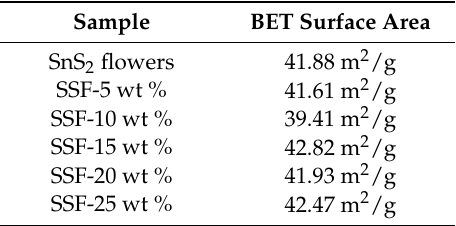
Table 1. Brunauer–Emmett–Teller (BET) surface areas of various SnS 2 -SiO2@ α -Fe2O3 (SSF-X) (X = 5, Table 1. Brunauer – Emmett – Teller (BET) surface areas of various SnS 2 - SiO2@α -Fe2O3 (SSF-X) (X = 5, 10, 15, 20, and 25 wt %) 10, 15, 20, and 25 wt %) nanocomposites.